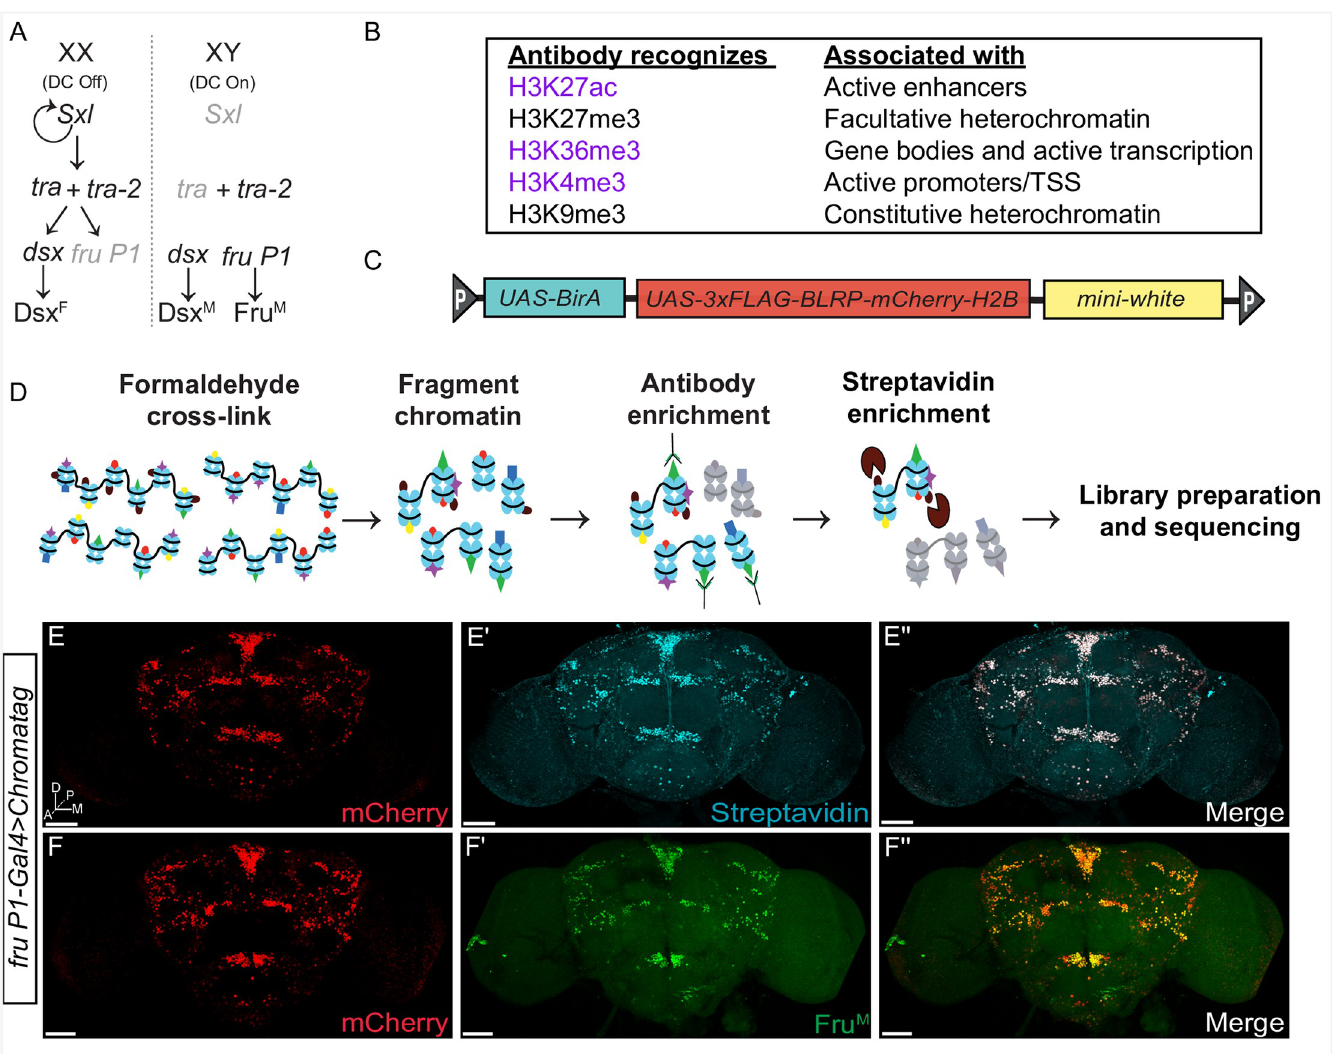
Fig 1. Chromatag methodology enables cell-type-specific ChIP in fru P1 neurons. (A) The Drosophila somatic sex determination hierarchy is composed of an alternative pre-mRNA splicing cascade dependent on the number of X chromosomes. Alternative pre-mRNA splicing of doublesex ( dsx ) and fruitless ( fru P1 ) products generates sex-specific transcription factors: Dsx F , Dsx M , and Fru M . Sex-specific Dsx and Fru regulate gene expression to yield sex differences in morphology, neuroanatomy and ultimately behavior [6,7,89] (B) Histone H3 modifications profiled in this study and their role in transcriptional activation (purple) or repression (black) [36–40]. Abbreviation: transcriptional start site (TSS). (C) Schematic of the Chromatag transgene. The construct includes three transgenes. One directs expression of amino-terminal tagged H2B under UAS control; the tag contains 3x-FLAG, the Biotin Ligase Recognition Peptide (BLRP) and mCherry . Another transgene directs biotin ligase ( BirA ) expression under UAS control. The mini-white transgene is a germline transformation marker. (D) Overview of the Chromotag- ChIP workflow. Tissue from flies expressing Chromatag is fixed with formaldehyde, the chromatin is isolated and then fragmented by sonication. An antibody to a histone modification is used in the first ChIP. A subsequent pull-down with streptavidin-bound beads enriches for cell-type-specific chromatin. The purified genomic DNA undergoes library preparation and sequencing. (E-F”) Immunostaining of 10–12 day adult male brains expressing the Chromatag transgene in fru P1 neurons. (E-E”) The Chromatag H2B variant is visualized by the mCherry tag (red) and overlaps with biotinylated H2B detected using fluorescently conjugated streptavidin (cyan). (F-F”) The Chromatag H2B variant is visualized by the mCherry tag (red) and overlaps with Fru M based on anti-Fru M immunostaining (green). Three- dimensional confocal maximum projections from successive confocal slices are presented, with the most anterior slice positioned first. Brain anatomical axes are presented on lower left of first brain image panel (see E ): D, dorsal ; M, medial ; A, anterior ; P, posterior . For Chromatag transgene expression at other time points in this study see S1 Fig . Further information on the Drosophila central nervous system, including anatomical structures and nomenclature, has been previously described [90,106]. (E-F”) Flies are the genotype: w/Y; P[w +mC , UAS-GAL4]/P[w +mC , UAS-Chromatag]; fru P1-Gal4/+ . Scale bars = 50 μ m.